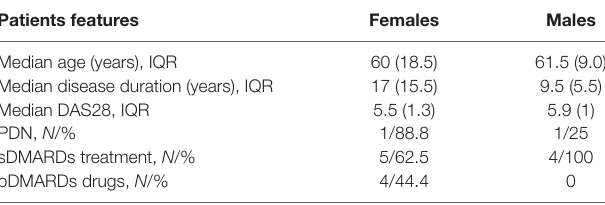
IQR, InterQuartile range; PDN, prednisone; DAS28, Disease Activity Score 28; sDMARDs, synthetic disease-modifying antirheumatic drugs; bDMARDs,